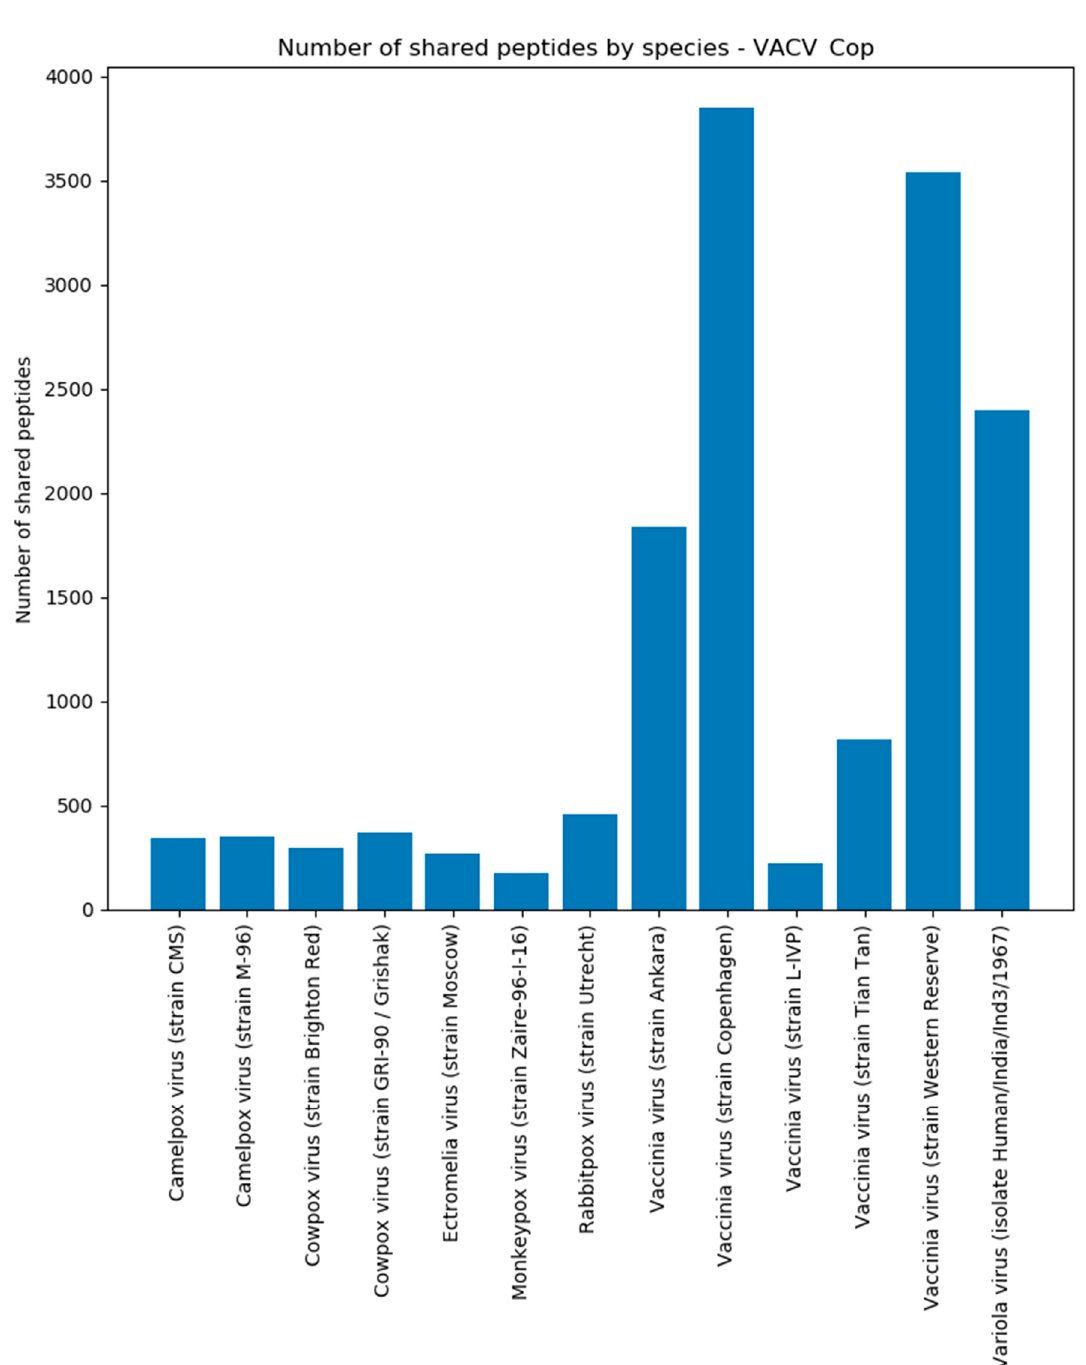
Figure 9. Number of shared peptides by species. This plot shows the number of shared peptides that Purple detected in the background for a species after the VACV Copenhagen analysis. All species that contribute less than 0.5% to the total amount of shared peptides were removed here.